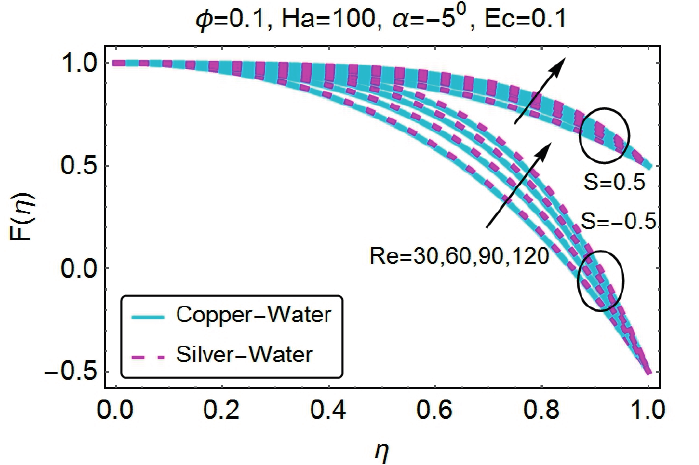
Figure 5. Change in velocity for varying Re (convergent channel).